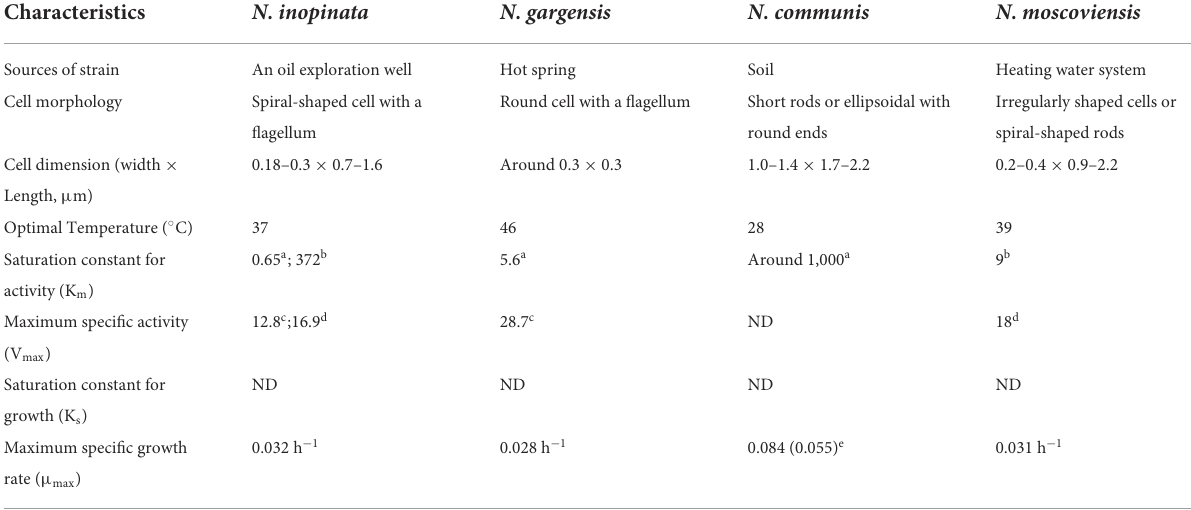
TABLE 1 Characteristics of four